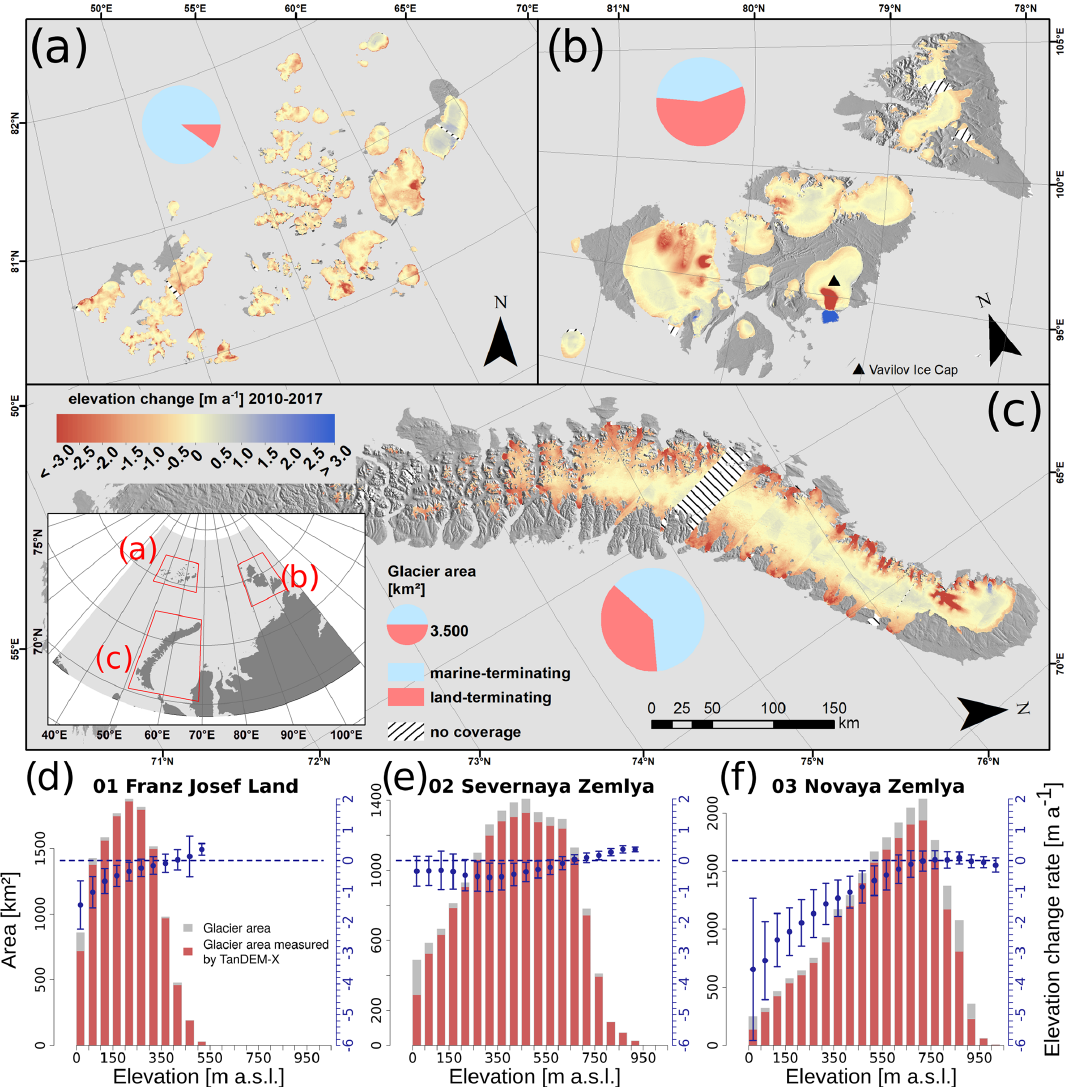
Figure 2. Surface elevation changes of glaciers on Franz Josef Land (a) , Severnaya Zemlya (b) , and Novaya Zemlya (c) between 2010 and 2017. Hatched areas indicate glaciers without coverage by TanDEM-X. Respective average elevation change rates and total and measured glacier areas within 50m elevation bins are shown in Fig. 1 (d–f) . Blue vertical bars indicate the normalized median absolute deviation of elevation change measurements of each elevation bin. The hypsometric distribution of Severnaya Zemlya does not include the surge of the Vavilov ice cap (RGI60-09.00971). Elevation changes at Novaya Zemlya were corrected for differences in seasonal SAR signal penetration (Fig.